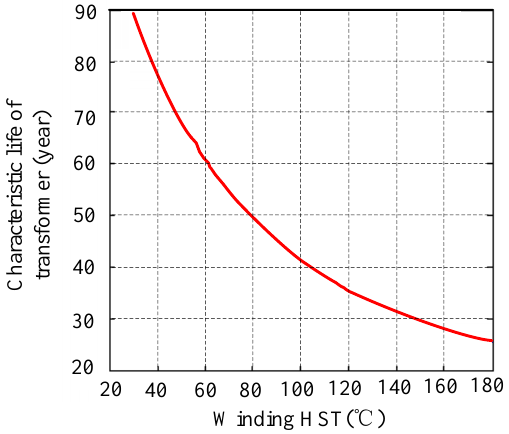
Figure 8. Curve of expected life vs. the winding HST.